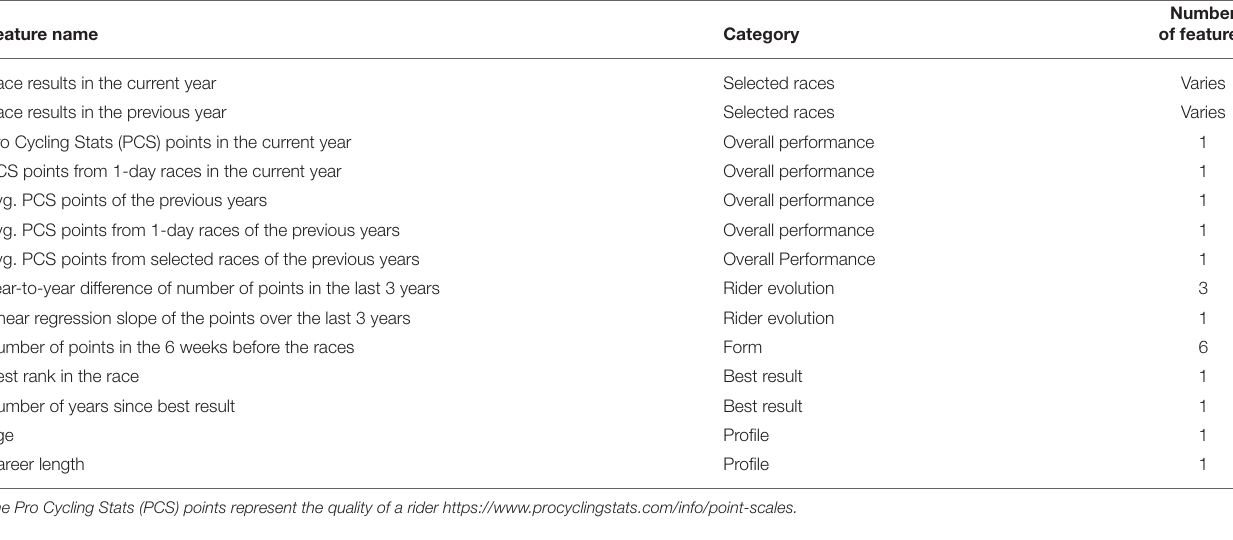
TABLE 1 | Summary of the features extracted for each of the riders of each race.